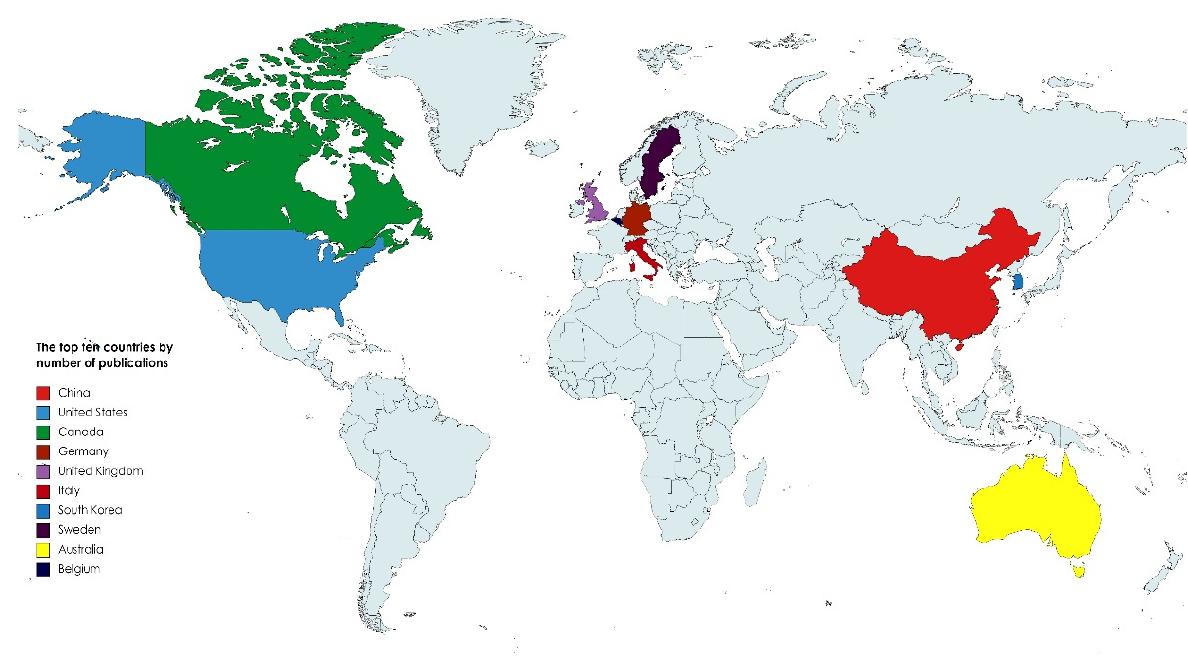
Figure 8. Distribution of the 110 most cited research articles in 10 countries with the most publications.